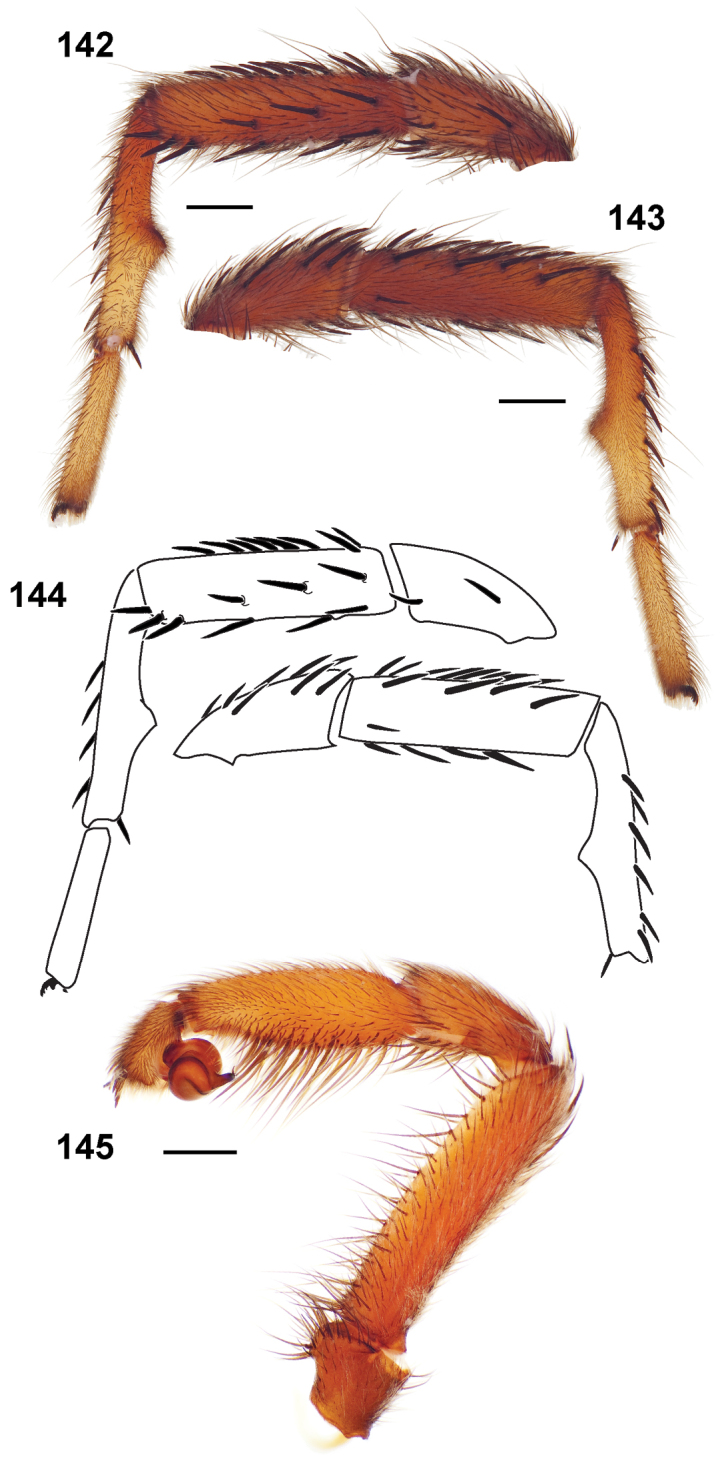
Aptostichus chiricahua sp. n. holotype specimen from Arizona, Cochise Co., Portal Arizona; scale bars = 1.0mm. 142–144 leg I 142 retrolateral aspect [806094] 143 prolateral aspect [806090] 144 line drawings of leg I retrolateral and prolateral aspects 145 retrolateral aspect, pedipalp [806096].